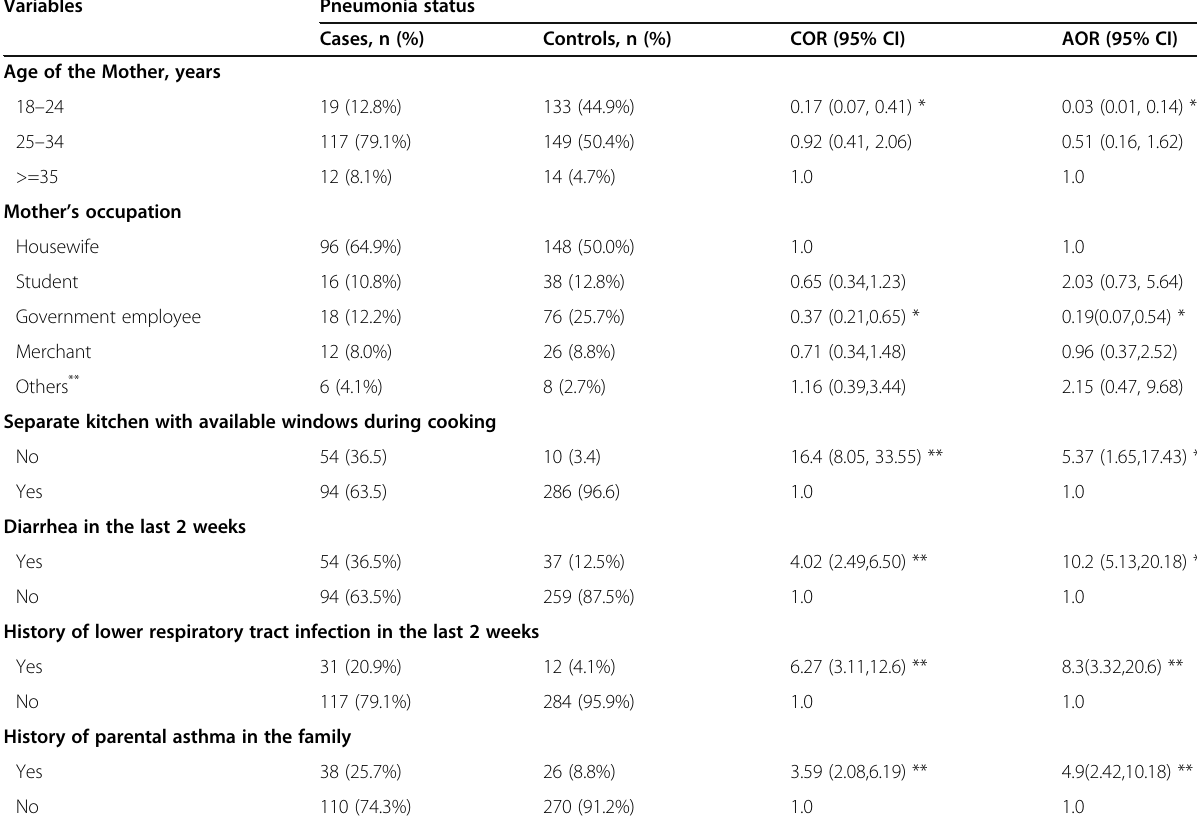
Table 5 Determinants of community-acquired pneumonia among children 2 – 59 months of age in Northeast Ethiopia, 2019